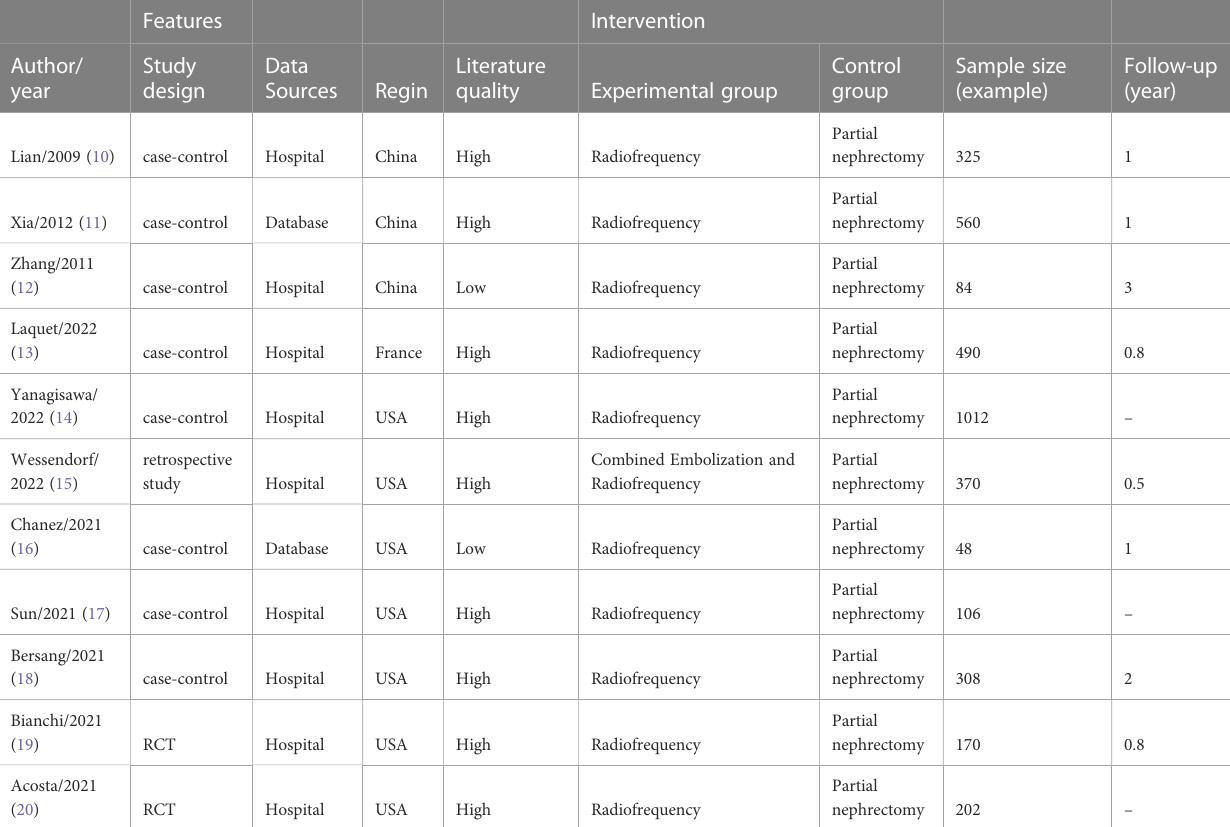
TABLE 1 Basic characteristics of included studies.